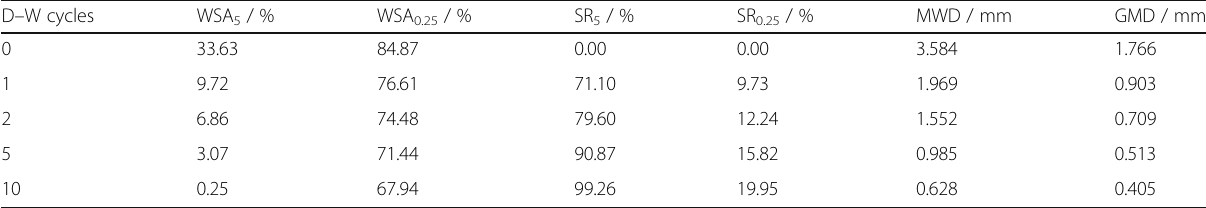
Table 3 Characteristic parameters of soil aggregates under drying – wetting cycles D – W